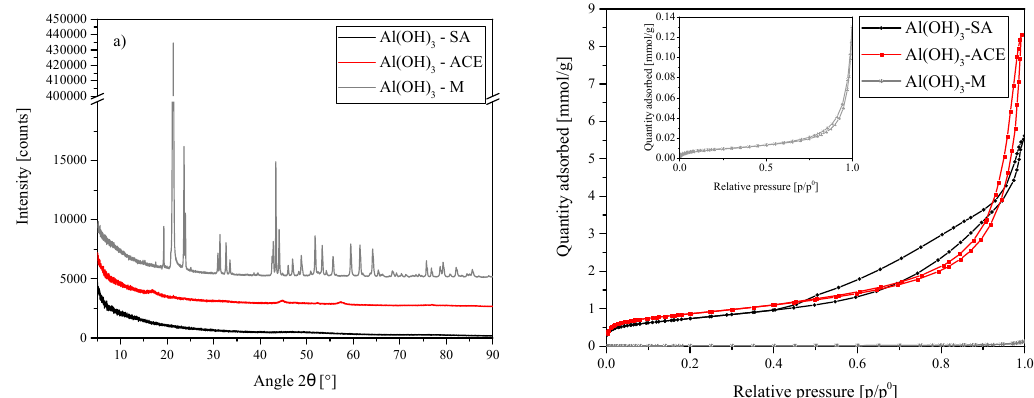
Figure 14. ( a ) XRD results of the Al sources used for the synthesis of A1, A2 and A3. SA = amorphous, ACE = boehmite and M = gibbsite—Sigma Aldrich (SA), ACE Chemicals (ACE) and Merck (M). Each scan is y-shifted by 2500 counts. ( b ) Isotherms obtained for each Al source. Sigma Aldrich (SA), ACE Chemicals (ACE) and Merck (M).